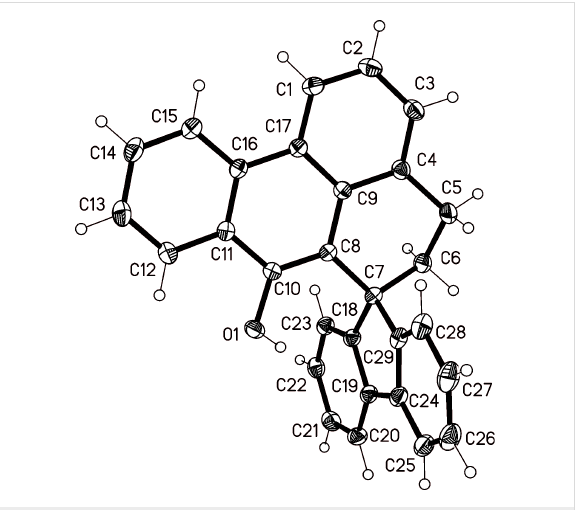
The molecule of compound 11 is shown in Figure 4. The bond length C10-O1 of 1.375(1) Å is consistent with a single bond, and the hydroxy hydrogen atom was located and freely refined.